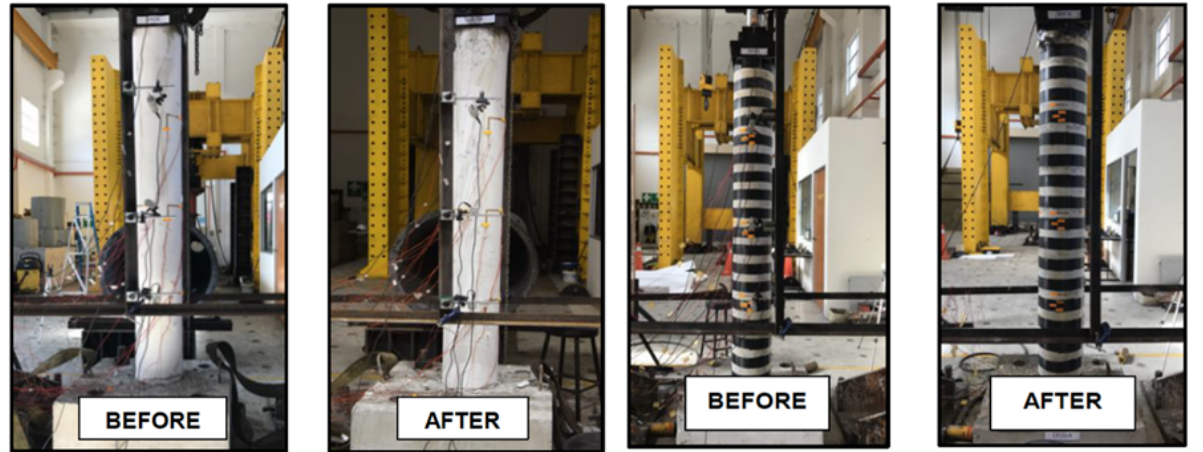
Figure 3. Failure behaviour of CHRCC Before and After Concentric